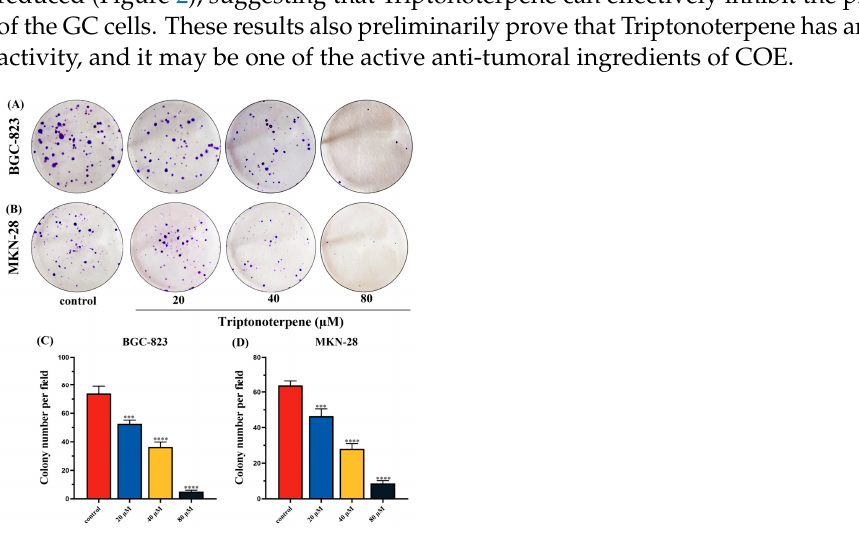
Figure 2. Cell proliferation was examined by the cell colony formation experiment. ( A , C ) Number of clones of the BGC ‐ 823 cells treated with Triptonoterpene for 24 h. ( B , D ) Number of clones of the MKN ‐ 28 cells treated with Triptonoterpene for 24 h. *** p < 0.001 and **** p < 0.0001. 2.3. Triptonoterpene Inhibited the Adhesion of Gastric Cancer Cells to Cell Matrix In order to explore the effect of Triptonoterpene on the invasion and metastasis of the GC cells, cell adhesion experiments were performed to assess the adhesion ability of Triptonoterpene to the BGC ‐ 823 and MKN ‐ 28 cell stroma. The experimental results show that the number of adhesions of the Triptonoterpene group cells was significantly reduced (Figure 3). This finding suggests that Triptonoterpene can inhibit cells’ adhesion to the cell matrix at the beginning of cell invasion.